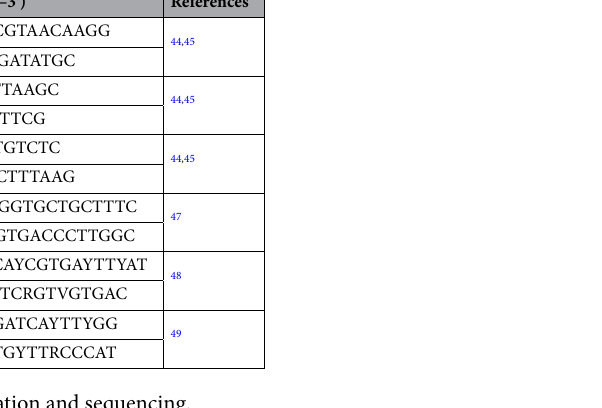
Table 1. Primers used for amplification and